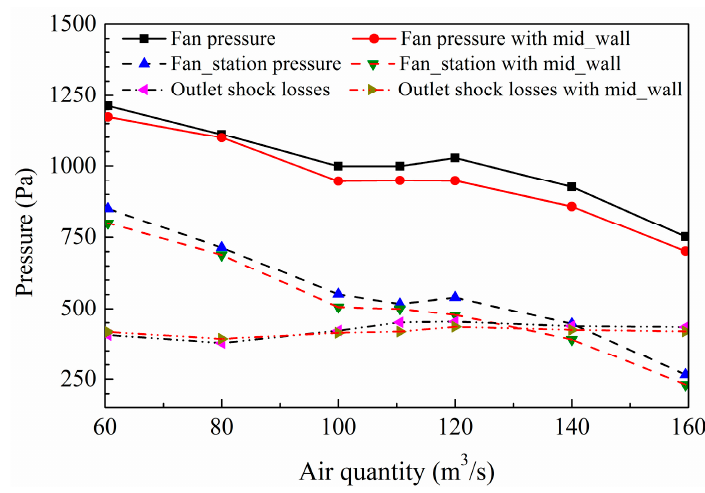
Figure 18. Comparison of pressure between mid_wall and without mid_wall in PFS.